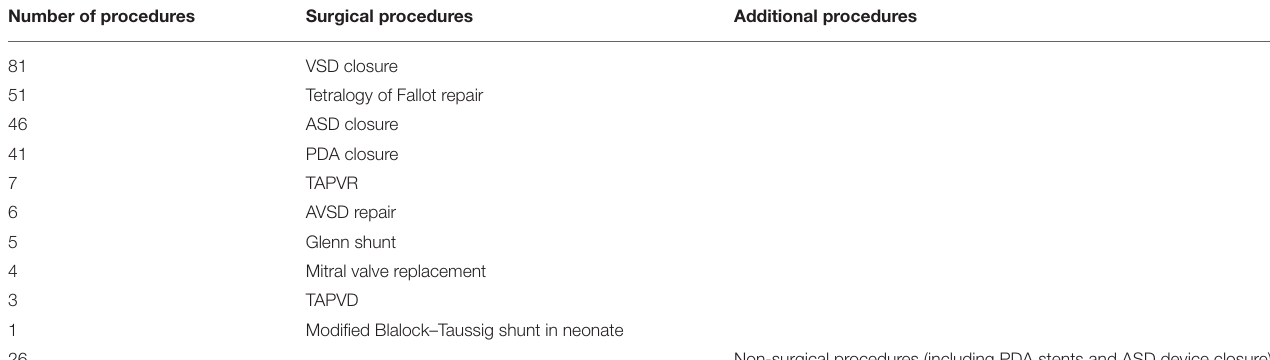
TABLE 1 | List of surgical and interventional catheter procedures performed by the travelling team between 1st April 2018 and 1st April 2019. Number of